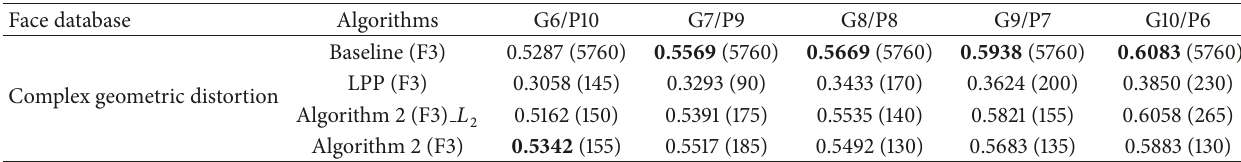
Table 25: The recognition rates on complex geometric distortion Extended Yale B face database over “F3” features; recognition rates (dimensionality).